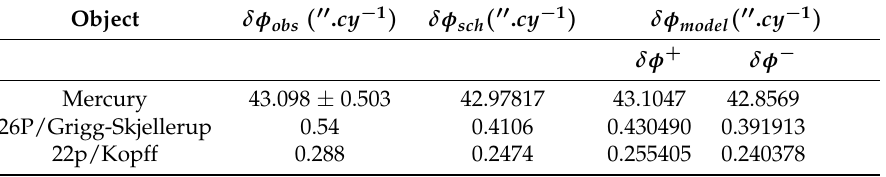
Table 1. Comparison between the values for secular precession of Mercury in units of arcsec/century of the standard (Einstein) perihelion precession δφ sch [45] and the nearly Newtonian solution δφ model . The δφ obs stands for the secular observed perihelion precession in units of arcsec/century adapted from [46] by adding a supplementary precession corrections from EPM2011 [42,43]—in addition, two Jupiter-family comets 26P/Grigg-Skjellerup and 22p/Kopff [47–49]. Object δφ obs ( (cid:48)(cid:48) . cy − 1 )